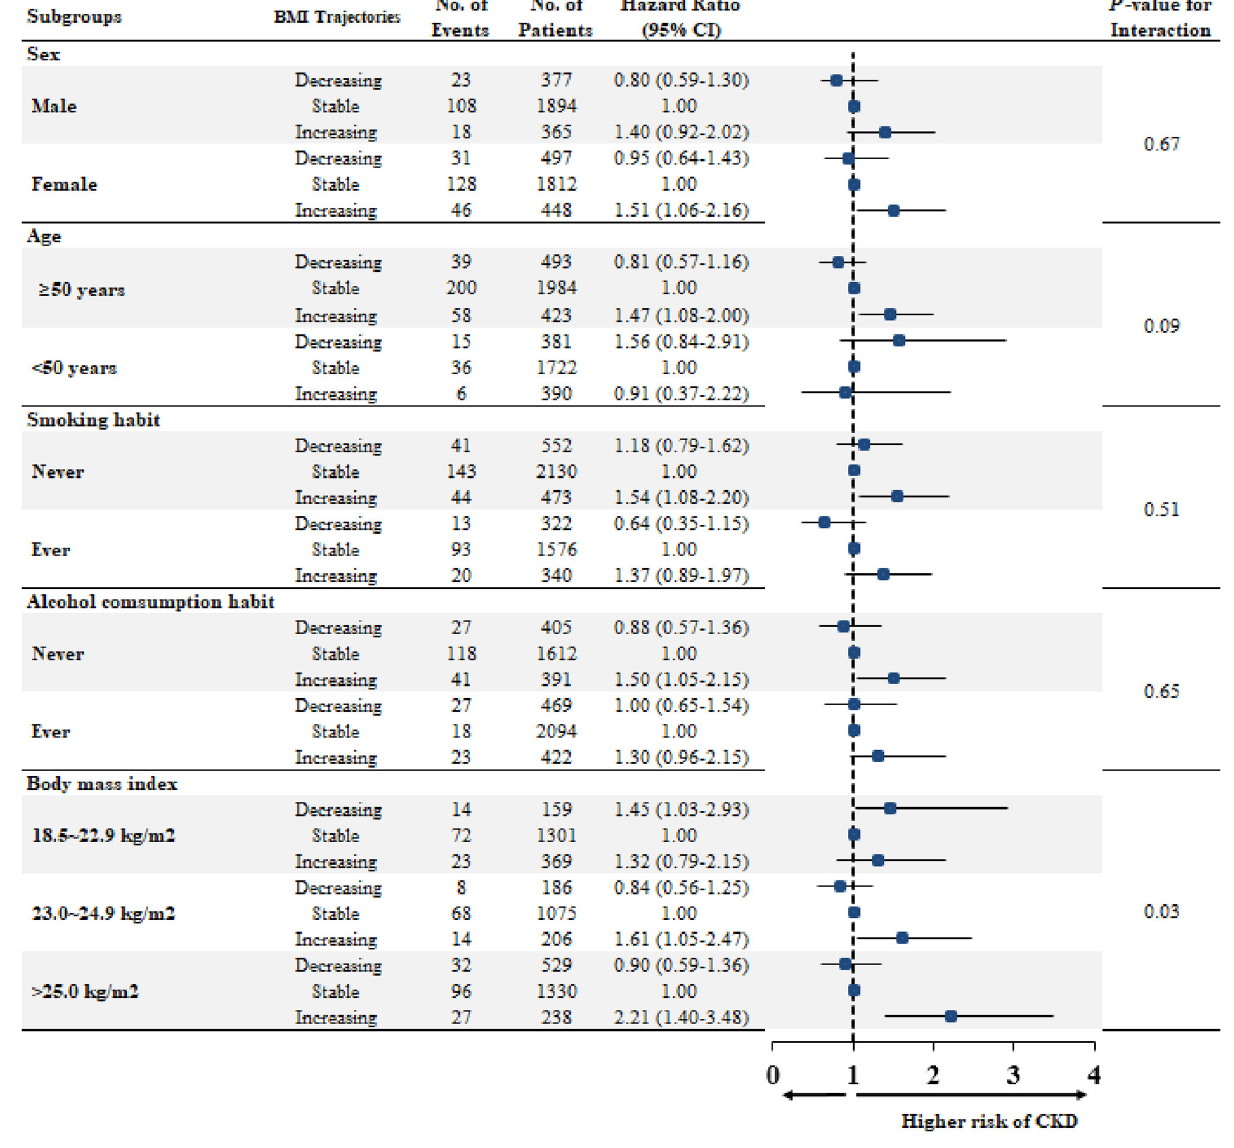
in the increasing BMI trajectory [ − 1.28 ( − 1.42 to −